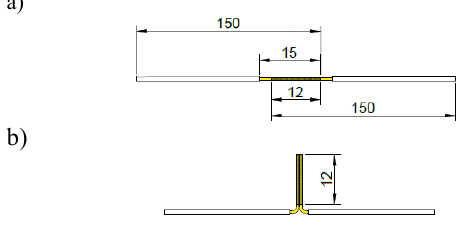
Fig 2. Layout of wires (all dimensions in millimeters).